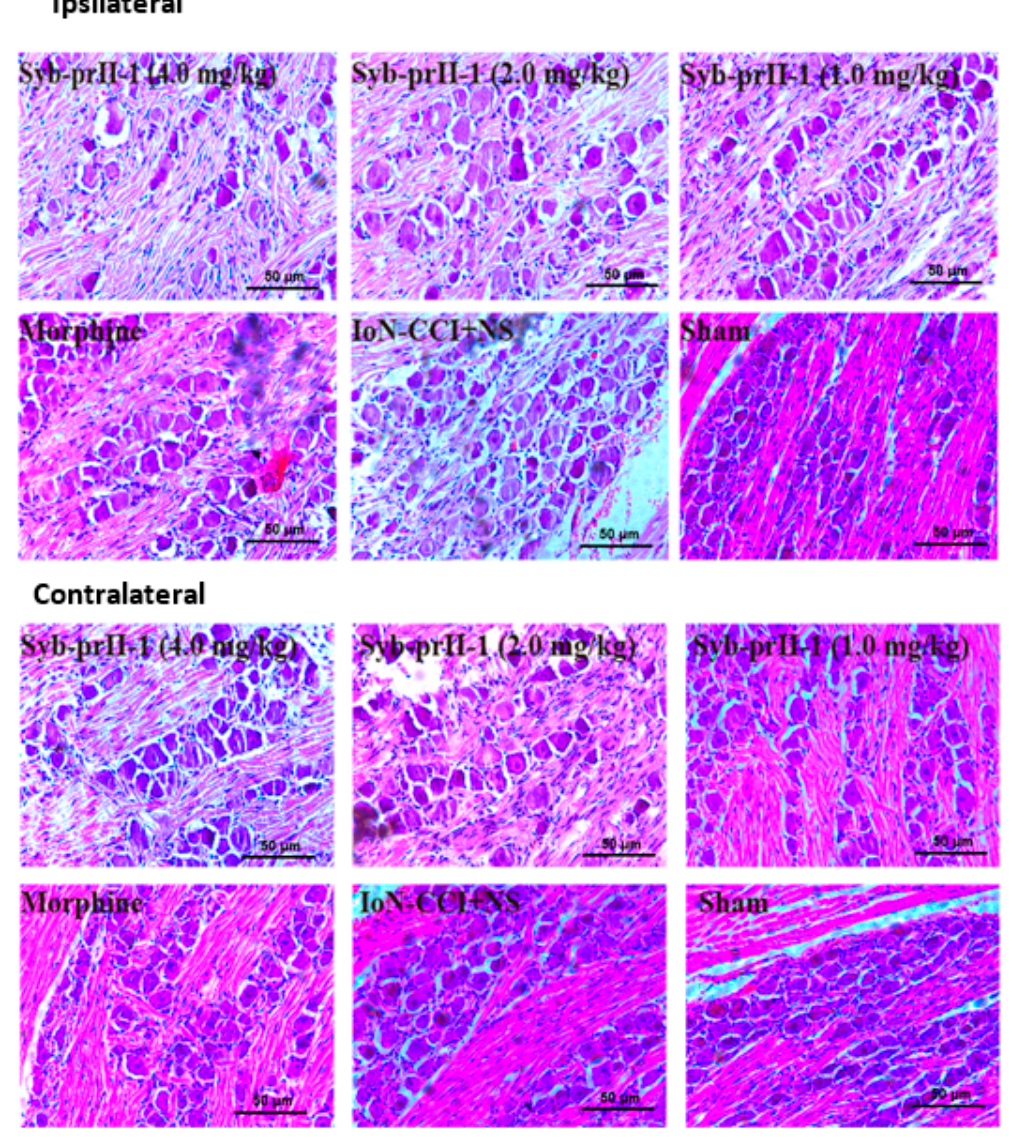
Figure 2. Behavioral changes in rats after IoN ‐ CCI model. ( A ) Changes of mechanical allodynia thresholds in response to the mechanical stimuli in the area of rats’ whisker pads. ( B ) Changes of thermal withdrawal latencies in the area of rats’ right whisker pads after gradient doses of Syb ‐ prII ‐ 1 treatment in rats. ( C ) Changes of scores of spontaneous asymmetrical facial grooming on the rats’ right whisker pads caused by Syb ‐ prII ‐ 1 and morphine. All data were presented as mean ± SEM. n = 12. * p < 0.05, ** p < 0.01, *** p < 0.001 compared with model group. ( D ) Histological examination of trigeminal neural ganglion from ipsilateral and contralateral sides in every group (×400, HE stain ‐ ing).